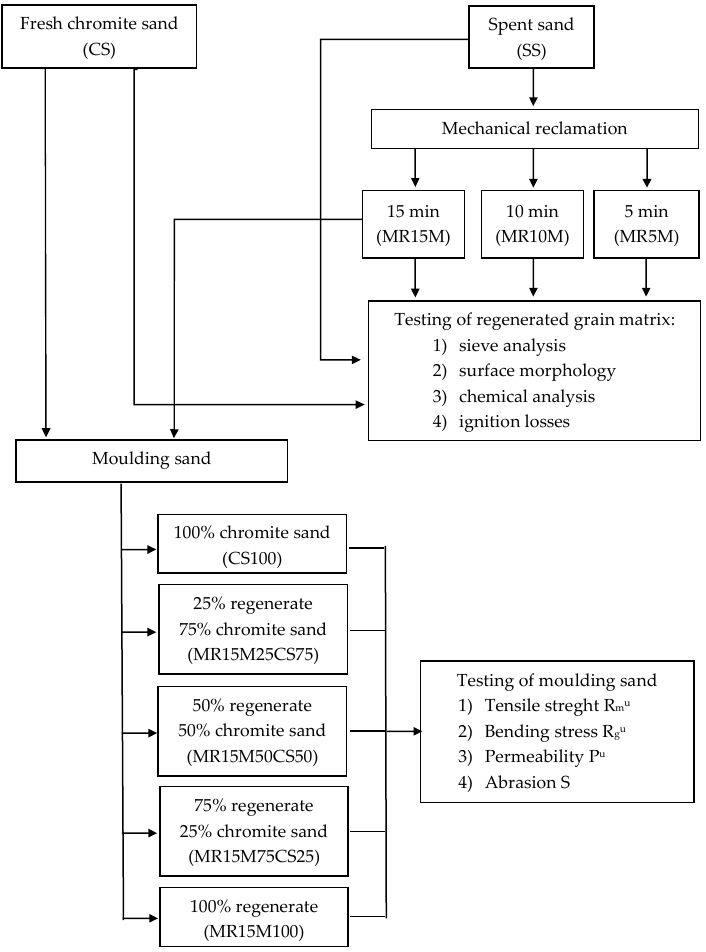
Figure 2. Flow chart of methodology.